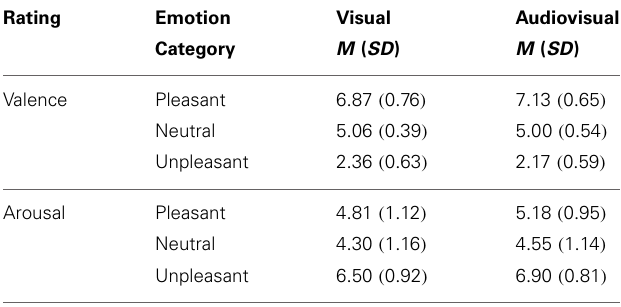
Table 1 | Mean and standard deviation for valence and arousal ratings of pleasant, neutral and unpleasant visual and congruent audiovisual presentations.